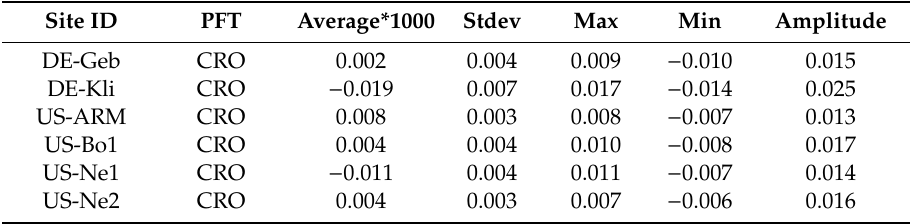
Table 4. Fourier modeling of NDVI is time series data on a site × year basis. PFT: Plant functional type; CRO: Cropland; DBF: Deciduous broadleaf forest; EBF: Evergreen broadleaf forest; ENF: Evergreen needle leaf forest; GRA: Grassland; OSH: Open shrubland; and WSA: Woody savanna. Average*1000: Average of first derivative of the NDVI is time series; Stdev: Standard deviation of first derivative of the NDVI is time series; Max: Maximum of the first derivative of the NDVI is ; Min: Minimum of the first derivative of the NDVI is ; Amplitude: Di ff erence between Max and Min of the first derivative